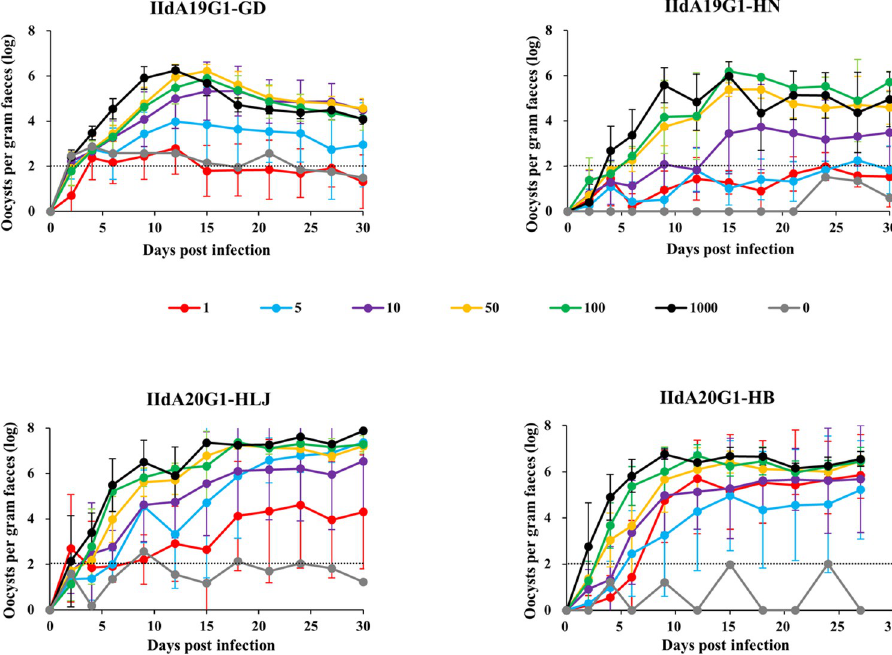
Fig 3. Oocyst shedding patterns of interferon- γ -knockout (GKO) mice infected with different doses of four Cryptosporidium parvum IId isolates. The detection threshold is indicated with a dotted line.